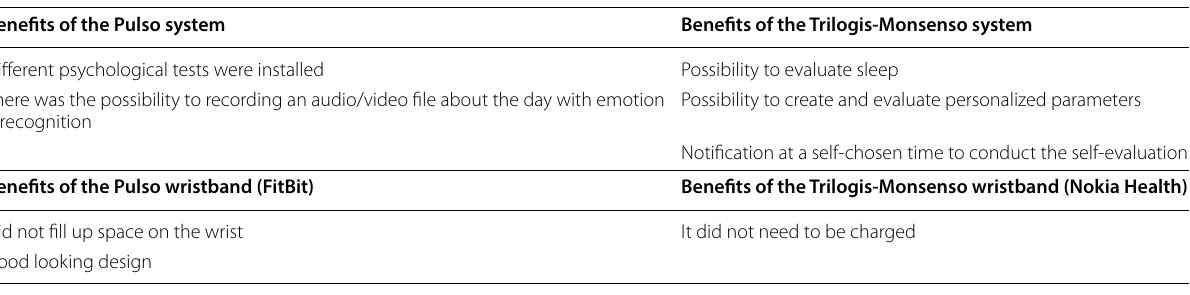
Table 2 Clinicians evaluation of benefits of the PULSO systems and the Trilogis-Monsenso systems and wristband